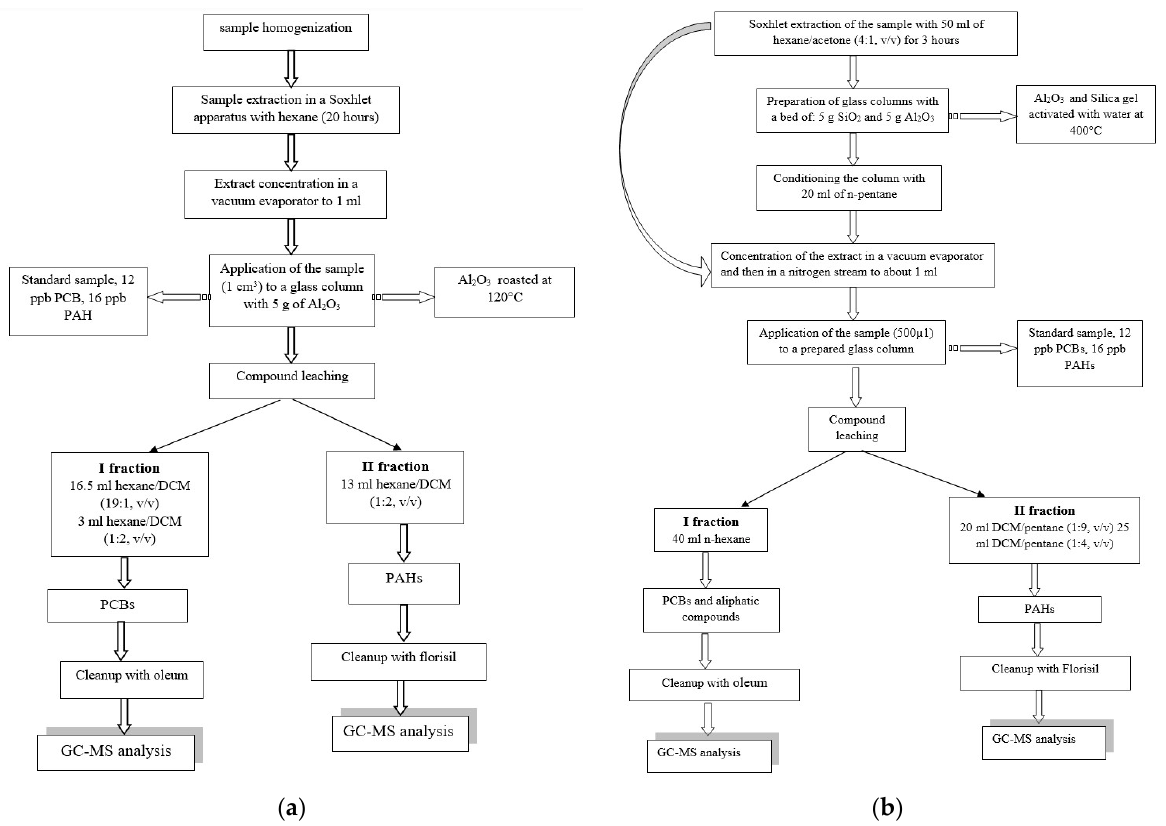
Figure 1. Procedures for determinations of PAHs and PCBs, according to Vives and Grimalt [32] (( a ), method 3) and Jaouen-Madulet et al. [33] (( b ), method 4).